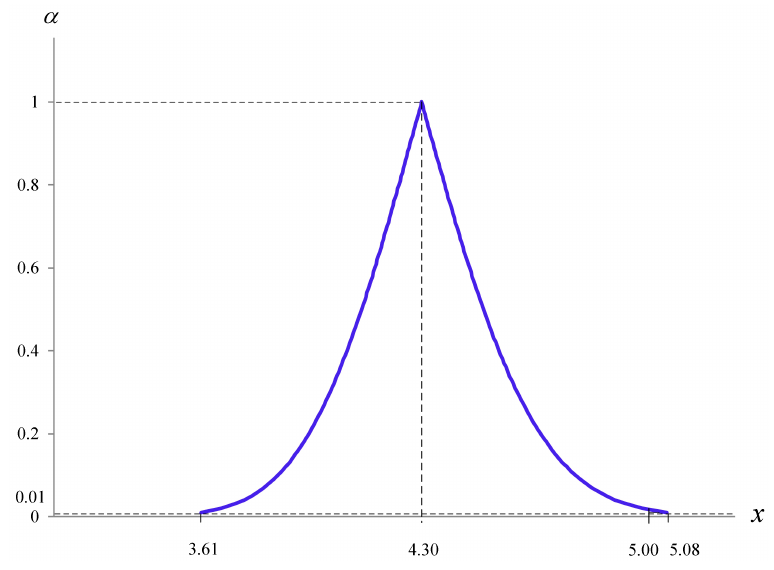
( x ) with vertical line x =